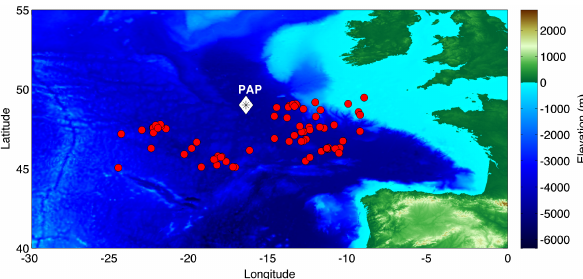
Figure 1. Map of the inter-gyre region of the northeast Atlantic showing the bathymetry around the PAP observatory (white dia- mond) and the ship of opportunity (SOO) sampling positions (red circles) from 2010 to